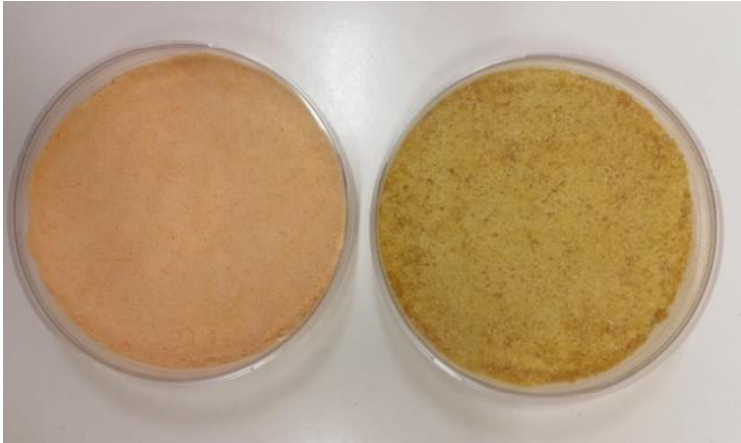
Figure 3. Visual appearance of native ( left ) and extruded-cooked ( right ) lentil flour.